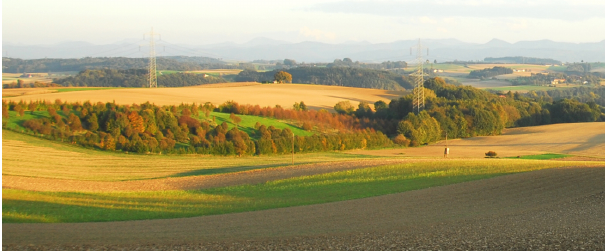
Figure 2. View of the Petzenkirchen HOAL catchment looking south (trees in the centre of the photo constitute the riparian zone of the Seitengraben stream).